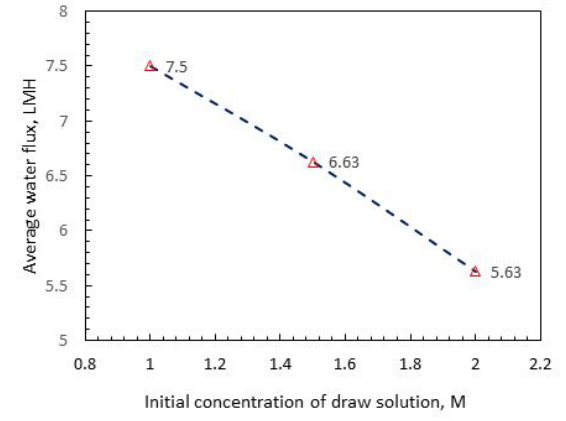
Fig. 7. Average water flux versus different initial draw solution concentrations (T= 25 0 C, feed solution: distilled water, draw solution: ascorbic acid, FO